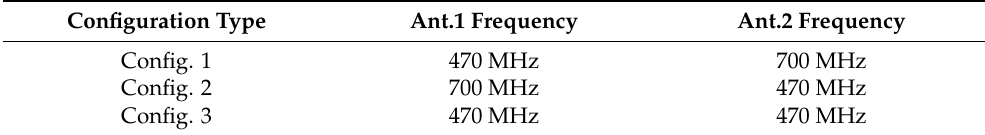
Table 2. Configuration of multiple